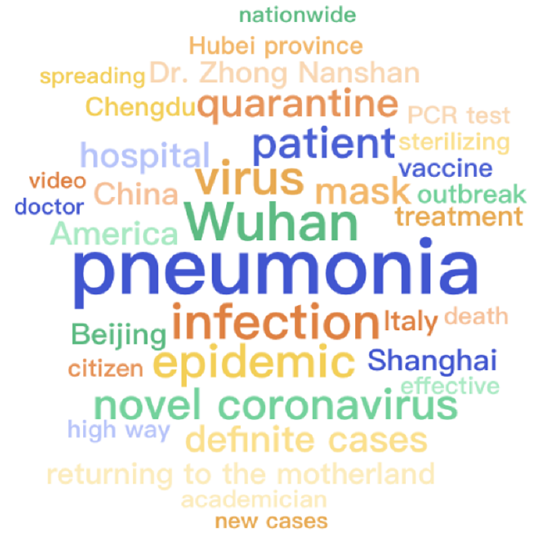
Figure 4. Word cloud of records labeled as questionable in the infodemic 2019 dataset.